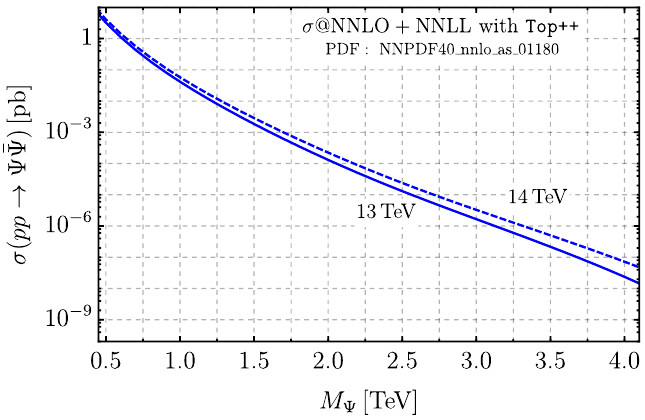
Figure 3 . The pair production cross-section σ ( pp → Ψ¯Ψ) for any color triplet calculated using Top++ [83] at the NNLO+NNLL accuracy with centre of mass energies